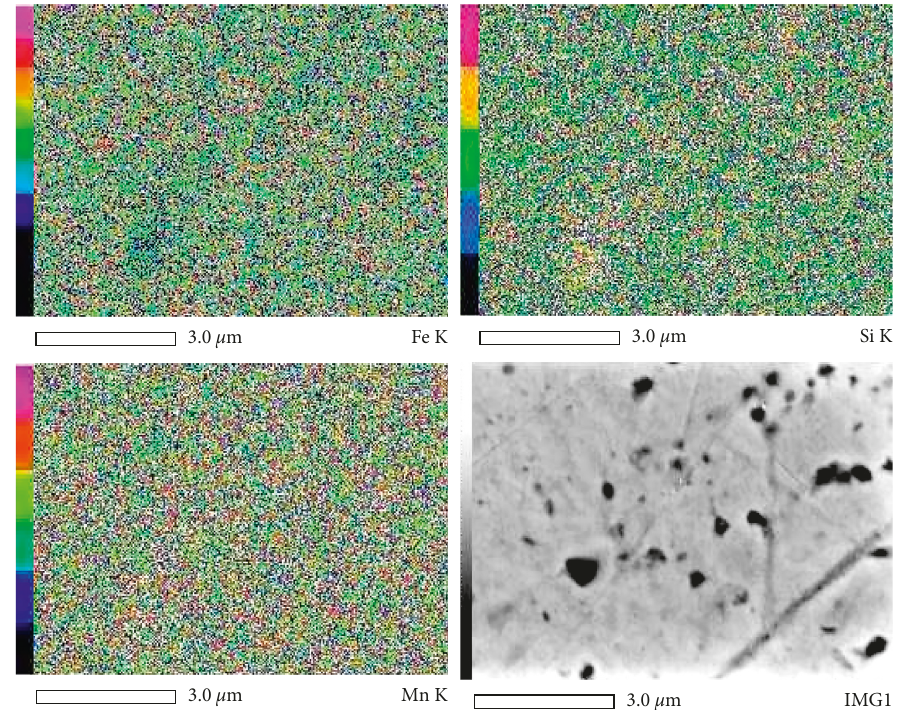
Figure 4: SEM and EDX analysis of Fe-30Mn-6Si bulk alloy after MA and subsequent